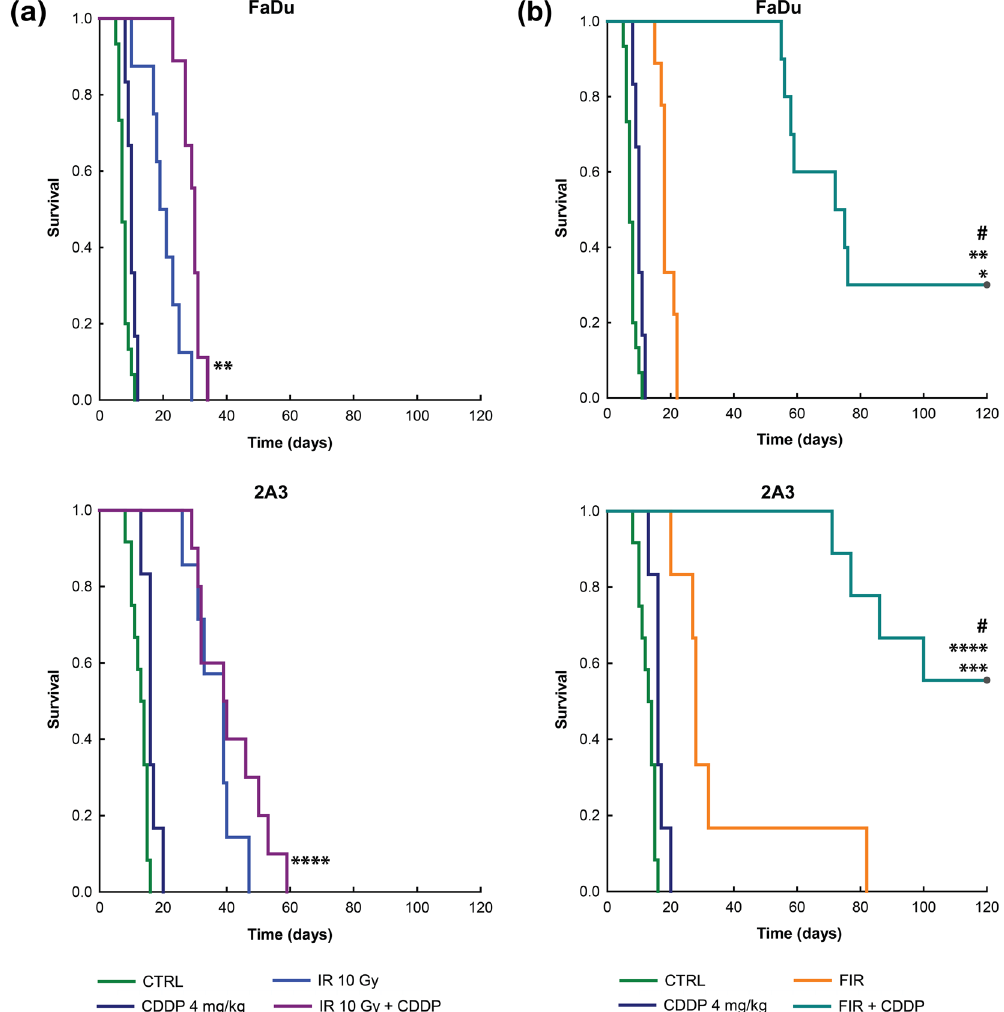
Figure 3. Kaplan-Meier survival curves of the mice with HPV-negative (FaDu) or HPV-positive (2A3) tumors after concurrent treatment with i.v . injection of cisplatin (CDDP) and single (IR) ( a ) or fractionated irradiation (FIR) ( b ). * p < 0.05 between treatments for FIR vs FIR + CDDP in FaDu tumors; ** p < 0.05 between treatments for IR 10 Gy + CDDP vs FIR + CDDP in FaDu tumors; *** p < 0.05 between treatments for FIR vs FIR + CDDP in 2A3 tumors; **** p < 0.05 between treatments for IR 10 Gy + CDDP vs FIR + CDDP in 2A3 tumors; # p < 0.05 between treatments for FIR + CDDP in FaDu vs FIR + CDDP in 2A3 tumors; n = 8–12 mice. CTRL, the control